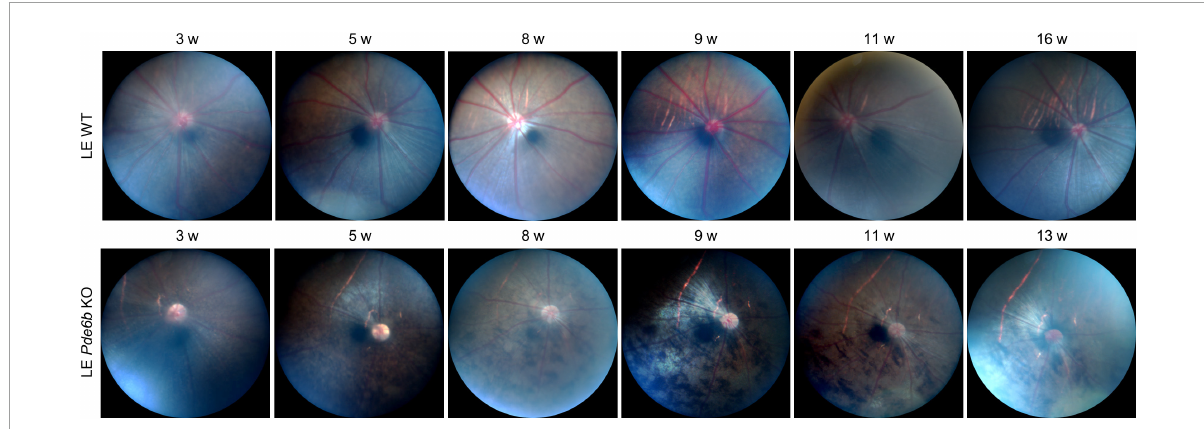
FIGURE2 Fundus changes associated with bone-spicule pigmentation in the Pde6b -knockout Long–Evans rats. Serial fundus photography showing marked development of the bone-spicule pigmentation, which is a hallmark of retinitis pigmentosa. LE WT, wild-type Long–Evans; LE Pde6b KO, Pde6b -knockout Long–Evans rat.